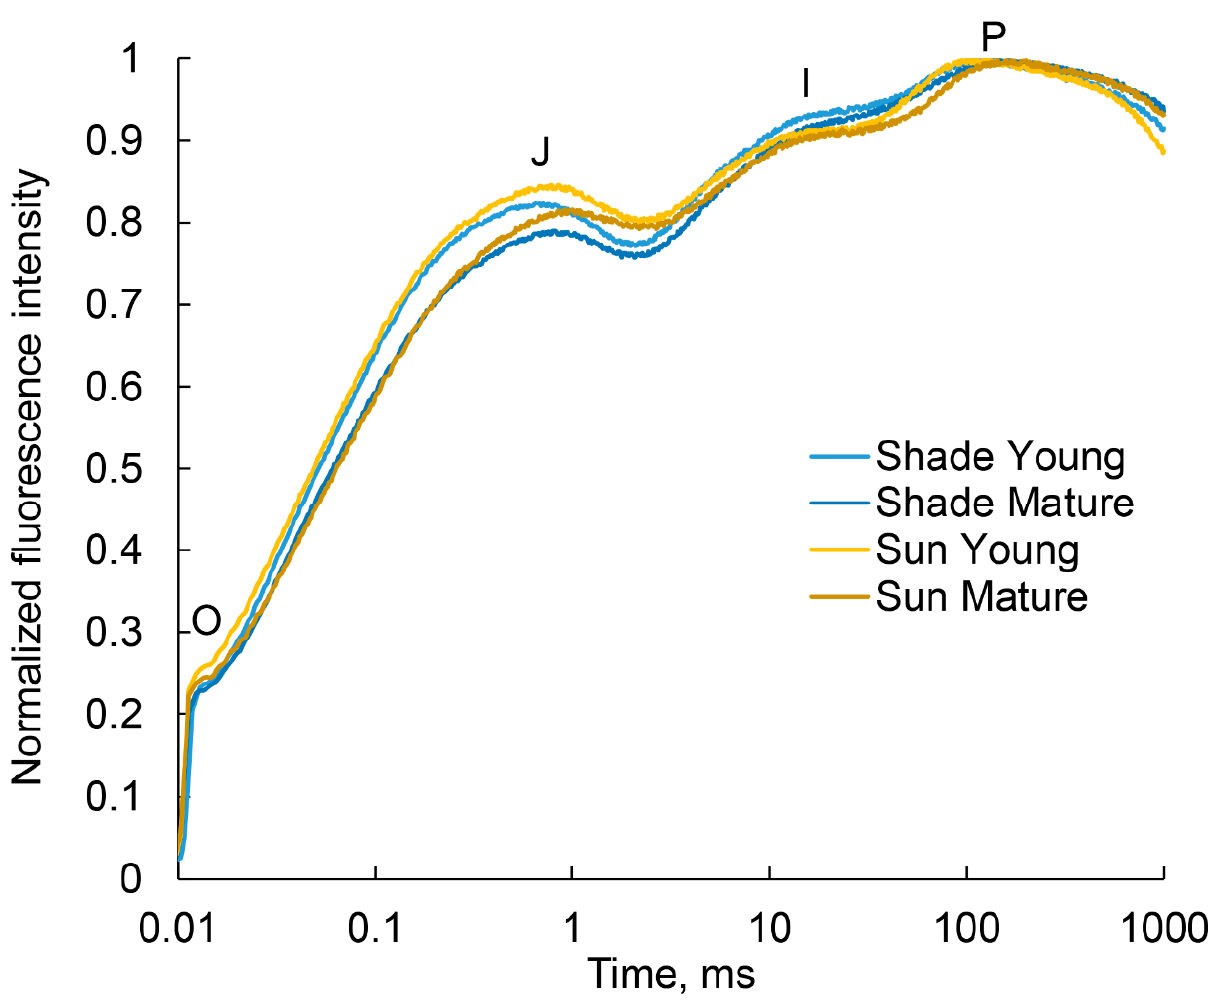
Figure 6. Anthocyanins/chlorophylls ( a + b ) ratio in young and mature leaves of Hydrocharis morsus- ranae in the different lighting.